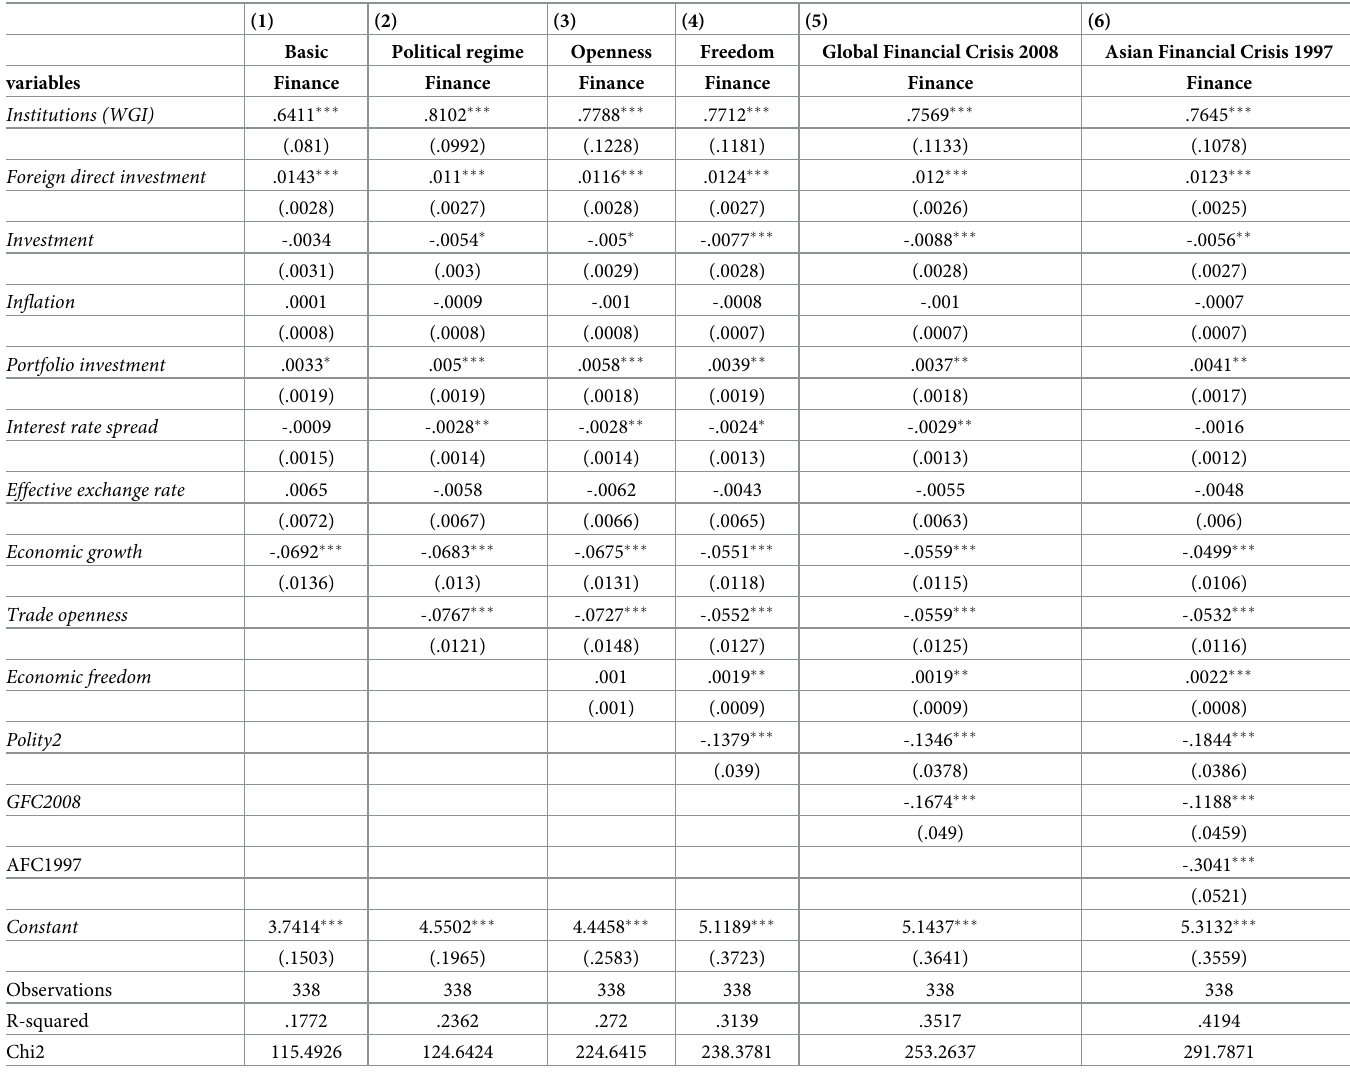
Table 8. Robustness with additional